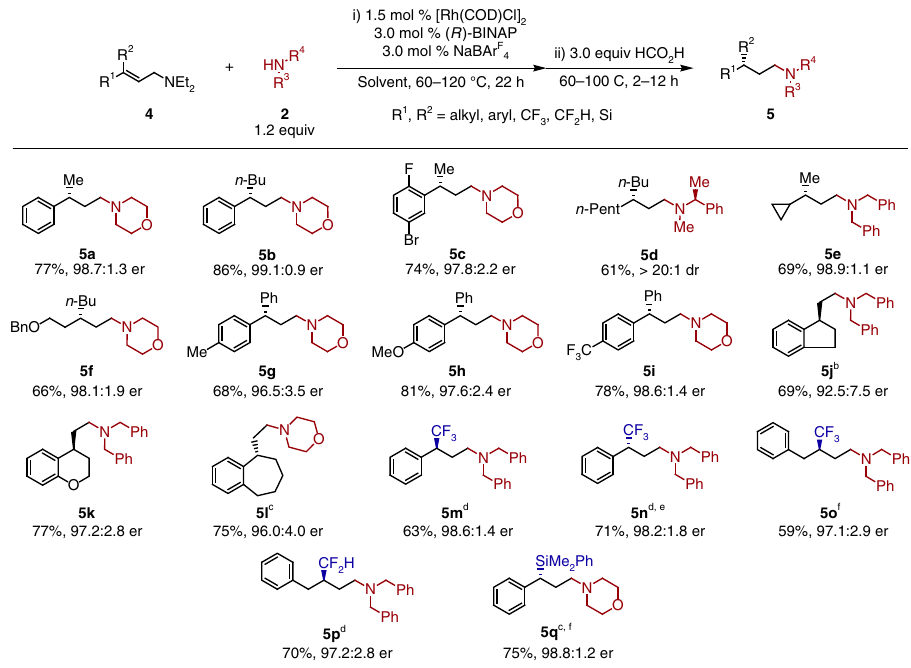
Fig. 4 Scope of allylamine. a: General reaction conditions: allylic diethylamine 4 (0.24 mmol, 1.0 equiv, E / Z > 99:1 unless otherwise noted), nucleophile 2 (1.2 equiv), HCO 2 H (3.0 equiv), THF (1.2 M). b: Substrate E / Z = 96.7:3.3. c: Substrate Z / E > 99:1. d: 1,4-dioxane used. e: Substrate Z / E = 95.6:4.4. f: Toluene used. See supplementary methods for details. The absolute con fi guration of product is determined by alkene con fi